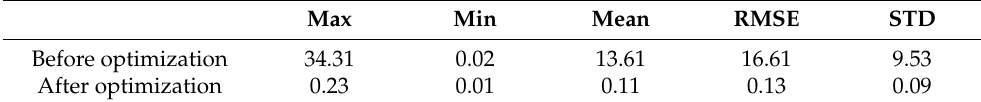
Figure 7. The comparison of trajectory before and after optimization with groundtruth. Table 1. Mapping performance comparison before and after optimization [35] (units: meter).